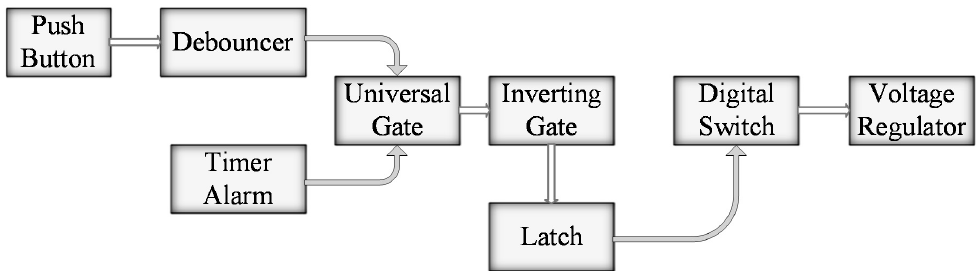
Figure 3. Functional block diagram of power management circuit.